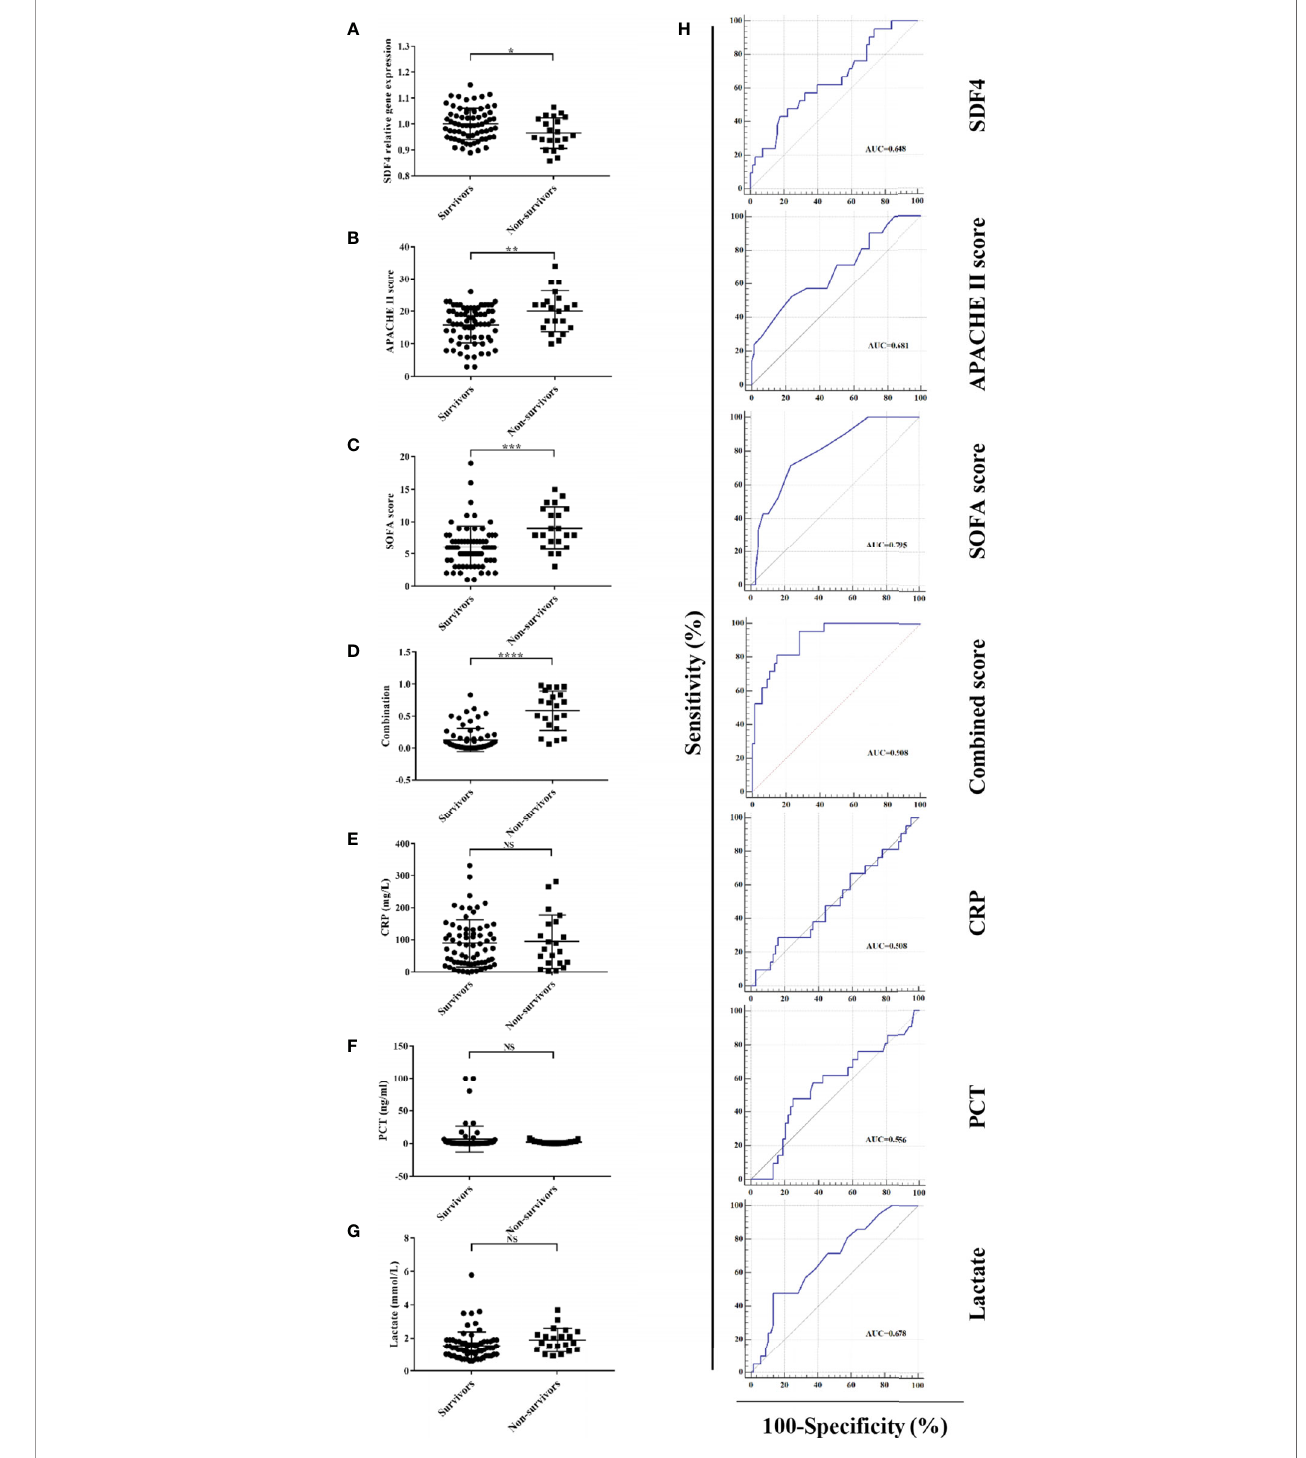
FIGURE 3 | (A) SDF4 expression in survivors (n=68) compared to non-survivors (n=21) within the cohort. (B) APACHE II score in survivors compared to non- survivors. (C) SOFA score in survivors compared to non-survivors. (D) Combined score in survivors compared to non-survivors. (E) CRP in survivors compared to non-survivors. (F) PCT in survivors compared to non-survivors. (G) Lactate in survivors compared to non-survivors. (H) Receiver operating characteristics (ROC) curve of a diagnostic test based on SDF4 expression, APACHE II score, SOFA score, combined score, CRP , PCT , and lactate. **** P < 0.0001, *** P < 0.001, ** P < 0.01, * P < 0.05. NS, not signi fi